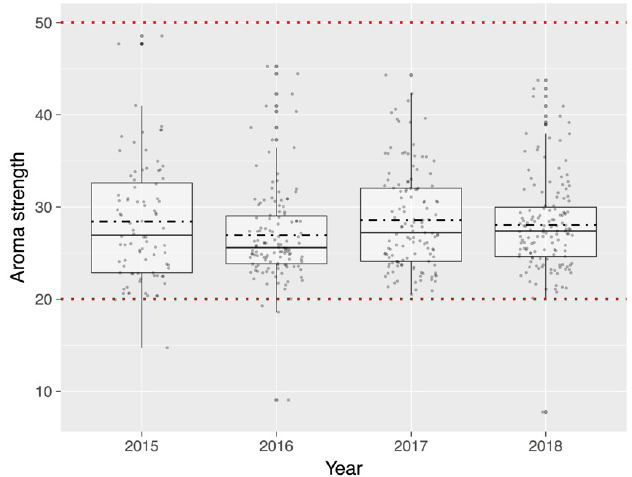
Fig. 3: Boxplots of aroma strength (safranal) of the saffron samples col- lected/analyzed during the four years (2015-2018). Red broken lines show the limits of the three quality categories (ISO 3632 1,2:2010- 2011). For each boxplot, mean (black broken line) and median (black line) were